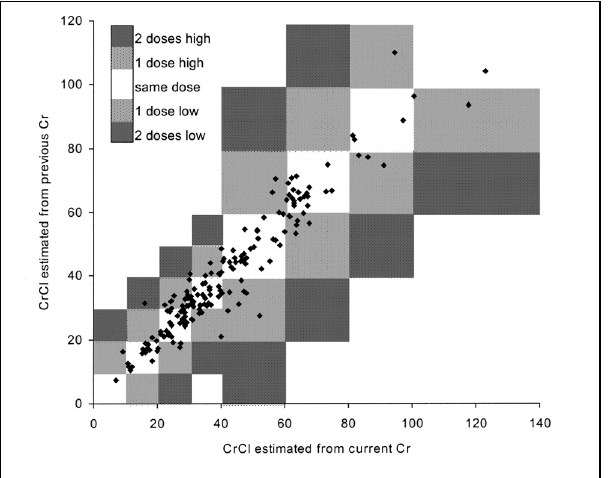
Figure 1) Scatter plot of creatinine clearance (CrCl [mL/min/1.73m 2 ]) estimated from current and previous (up to 18 months) plasma creatinine (Cr) results